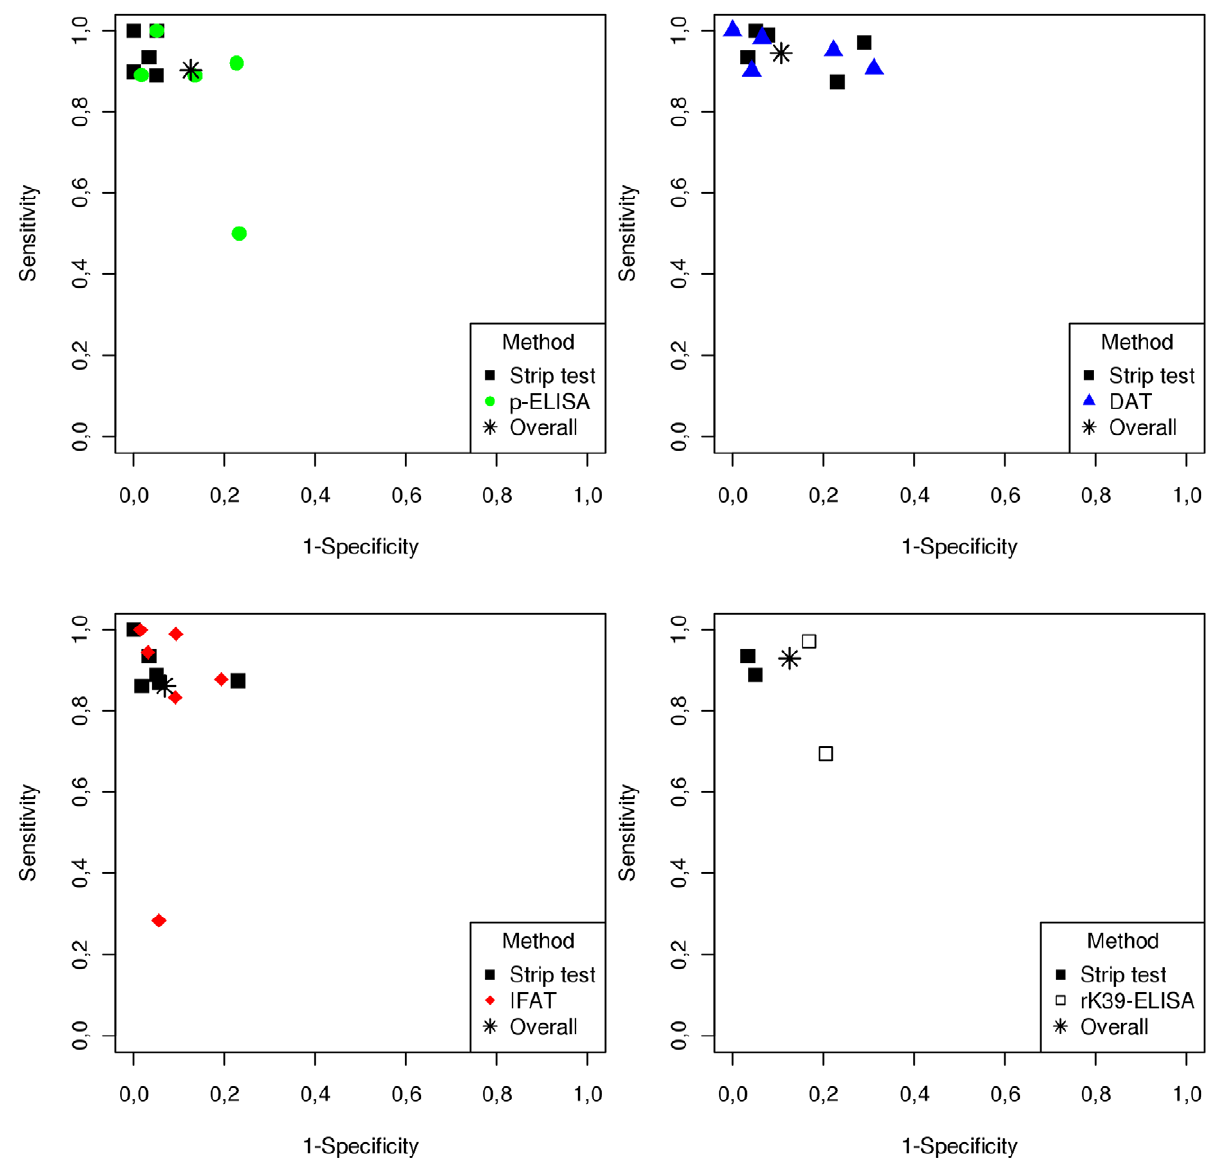
Figure 2. ROC plot comparing the performance of the rK39 strip test to serologic techniques utilizing promastigote antigens for diagnosis of Visceral Leishmaniasis.